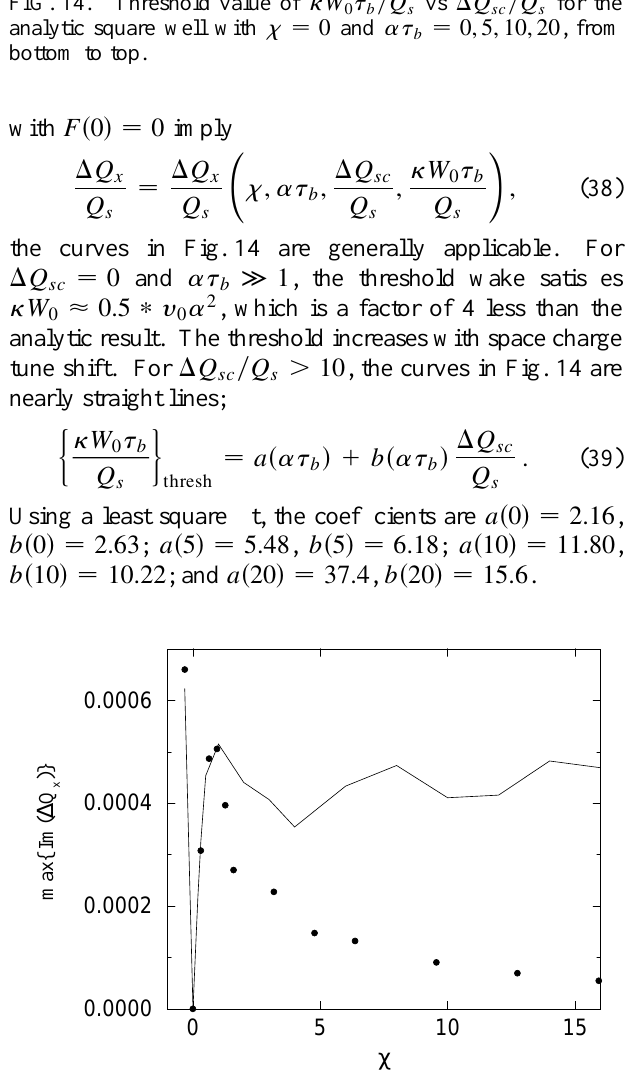
FIG. 15. Largest value of Im (cid:115) D (cid:81) (cid:120) (cid:100) vs x for D (cid:81) (cid:115)(cid:99) (cid:173) (cid:48) ,